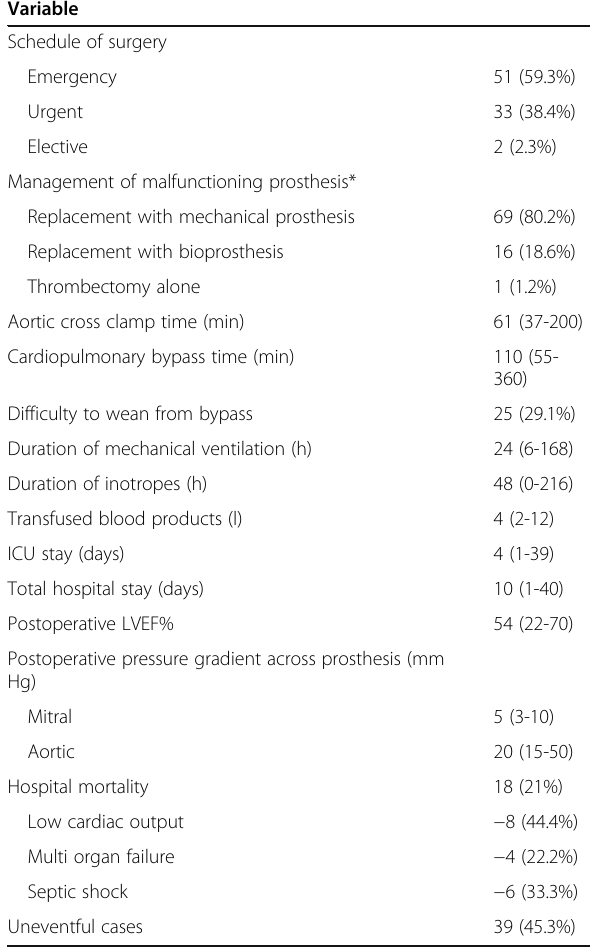
successfully managed by anticoagulant therapy, yet 2 Table 2 Selected operative and postoperative outcomes